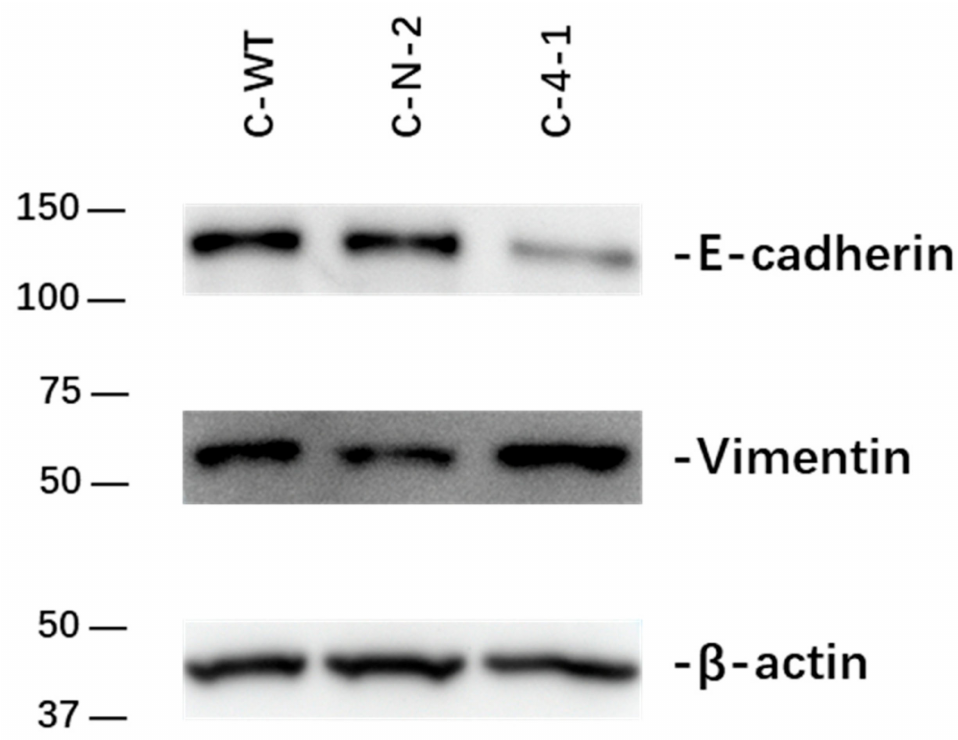
Figure 7. Immunoblot analysis of E-cadherin and vimentin in C-WT, C-N and C-KD clones. WB was performed to determine the expression of E-cadherin and vimentin in C-WT, C-N-2 and C-4-1 cells . β -actin was used as loading control. Downregulation of IL-13R α 1 leaded to reduced E-cadherin expression and upregulated the expression of